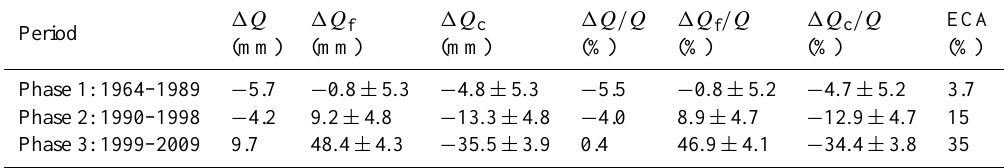
Table 4. Annual mean flow deviation and its components in different phases.